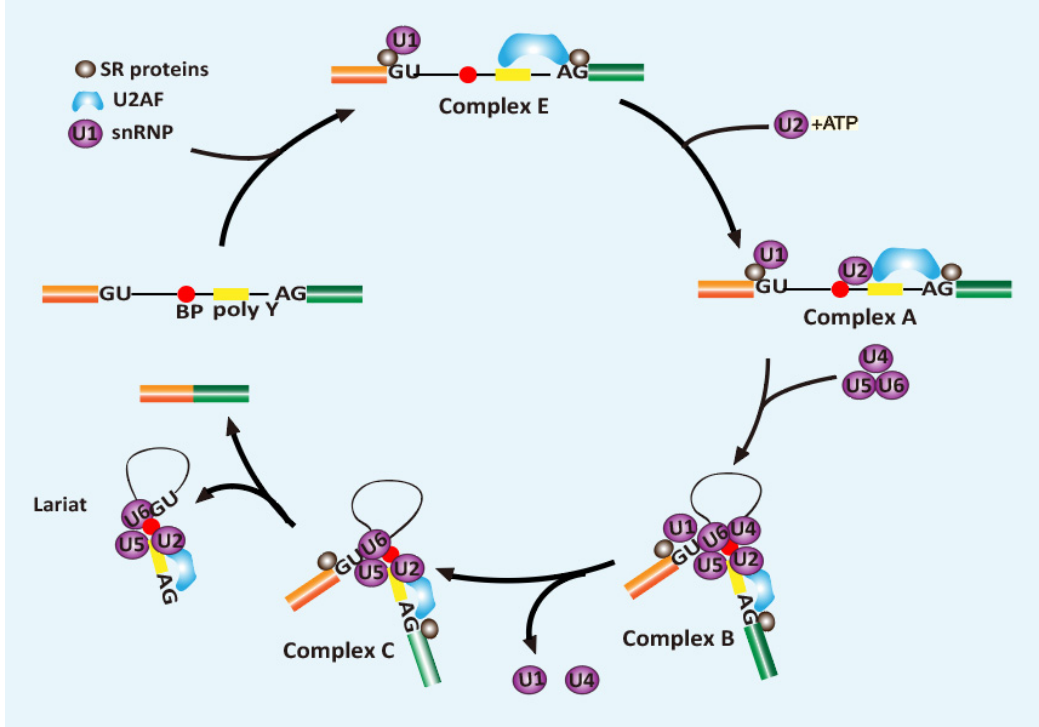
Figure 2. The role of SR proteins in spliceosome assembly. Many studies have identified SR proteins involved in nearly every step of the spliceosome assembly. Firstly, SR proteins could promote the formation of E complex and its binding to the 5’-splice site to facilitate base pairing between U1 snRNA with the splice site. Next, SR proteins recruit U2 snRNA to the branch point region of pre-mRNA to form complex A. Then SR proteins form a bridging complex across two splice sites via binding to U2AF at the 3 ′ -splice site and U1 70K at the 5 ′ -splice site, facilitating the recruitment of U4/U6 and U5 tri snRNP complex to form complex B.